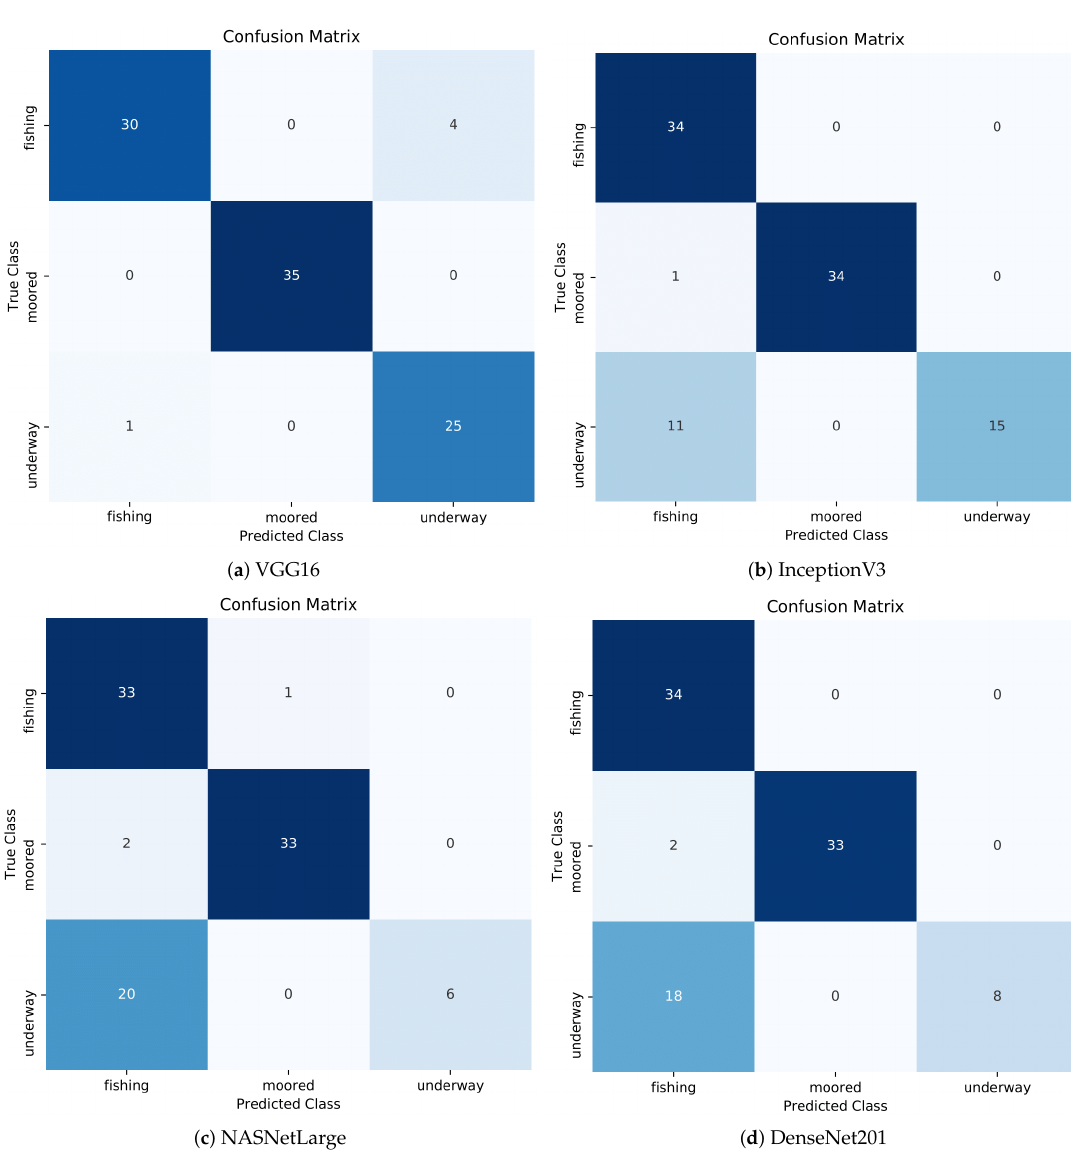
Figure 14. Confusion matrix of deep learning models for Pattern B with the best classification performance out of the five